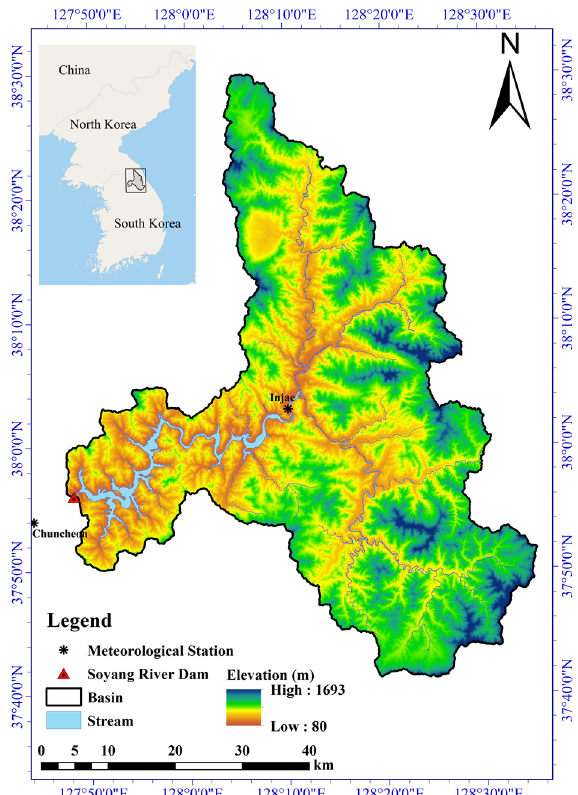
Figure 1. Study area.